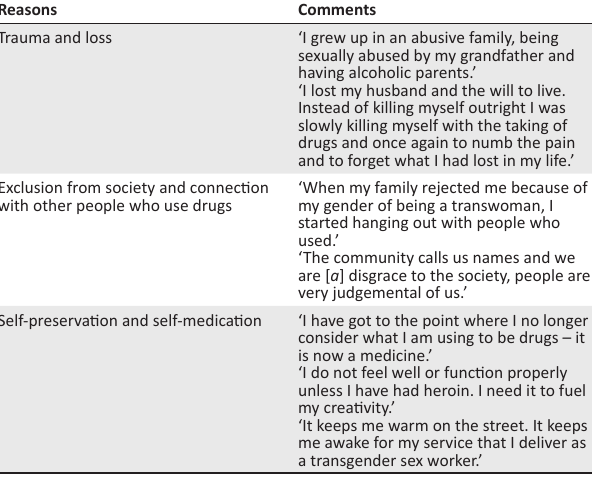
TABLE 5: Insights into reasons for drug use amongst people with unstable housing, South Africa (2015).